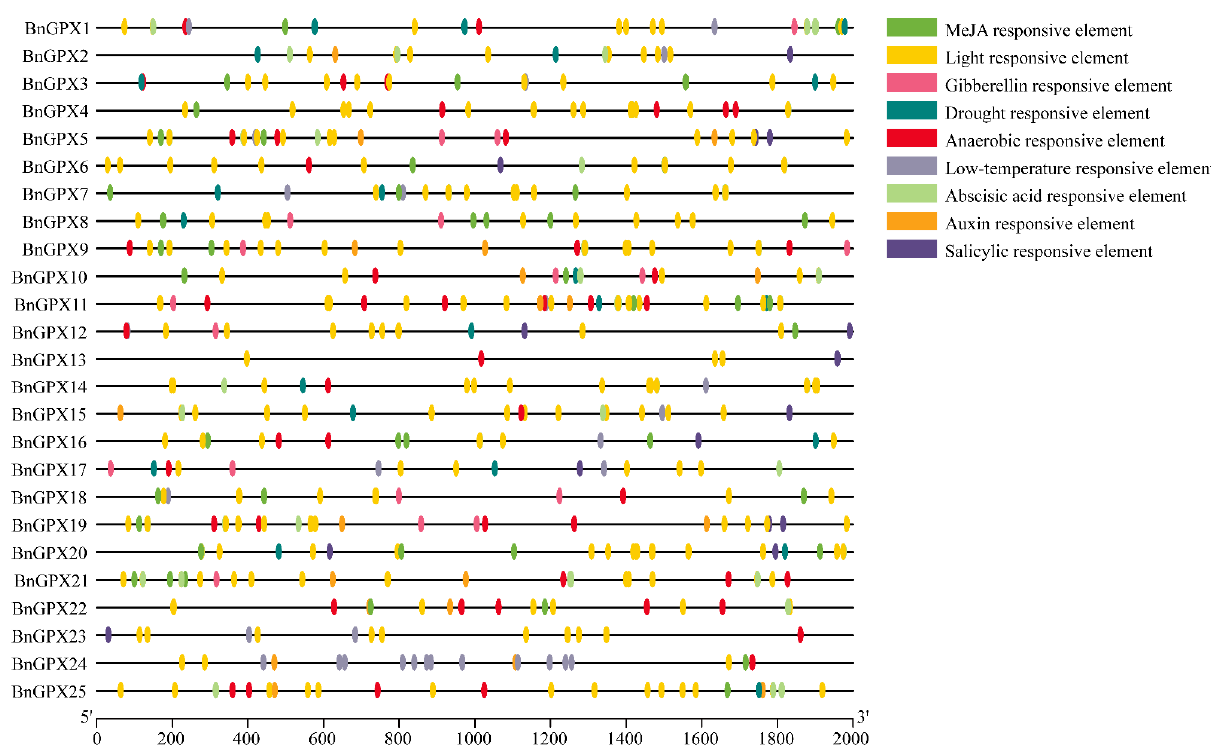
Figure 5. Evaluation of cis -regulatory elements in the BnGPXs promoters’ regions that are linked with various hormone- and stress-responsive elements. Unique color boxes display unique identified cis -elements.